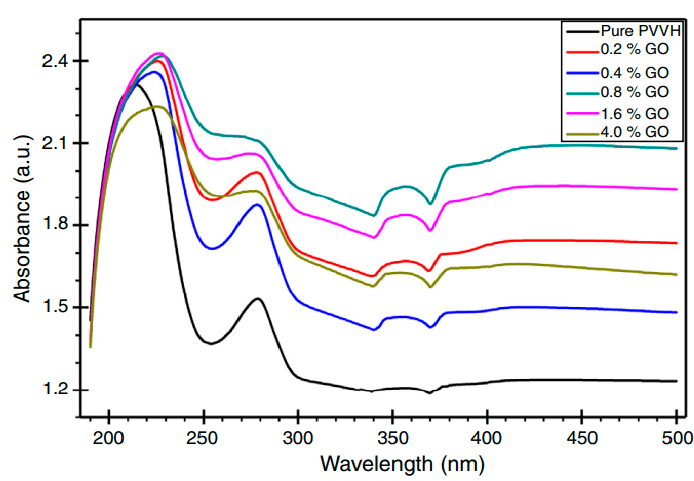
Figure 23. Pure PVVH and PVVH/GO nanocomposites absorption spectra in the range from 190 to 500 nm at ambient temperature [229].